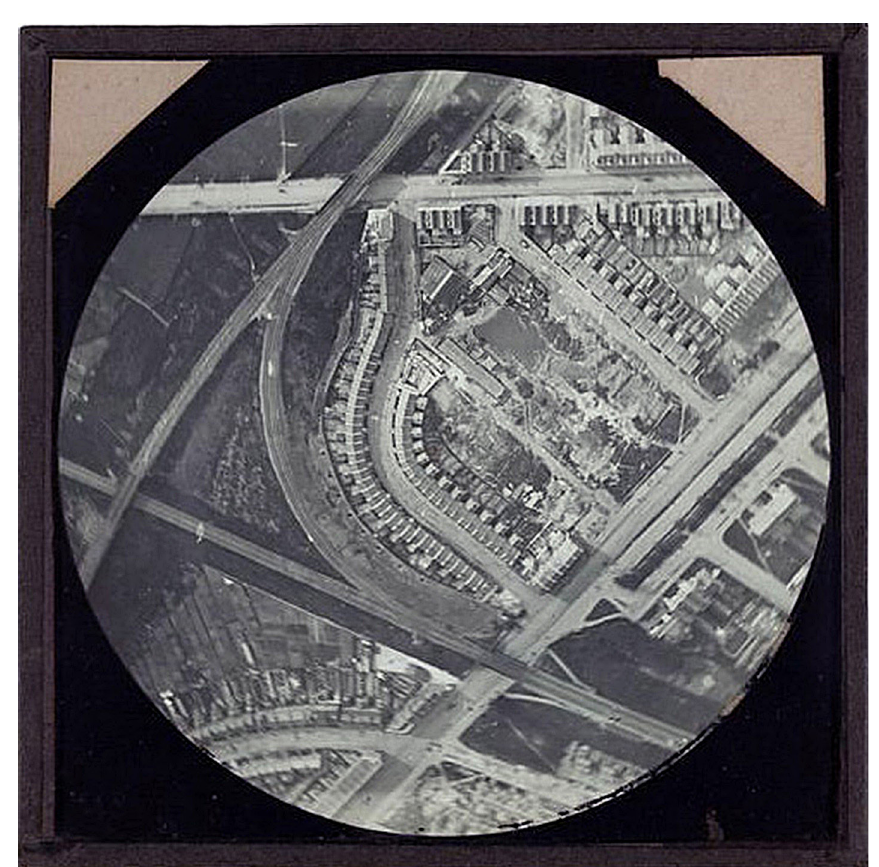
Fig. 2. Stamford Hill, Stonebridge Road & Tottenham and Hampstead Junction Railway – first vertical aerial photograph, Cecil Shadbolt, 610m, 29 May 1882. Source: Wikimedia Commons, from the collections of